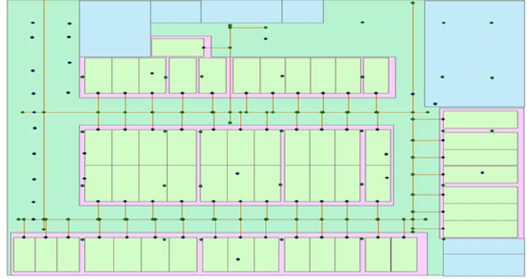
Figure 10. Experimental site.